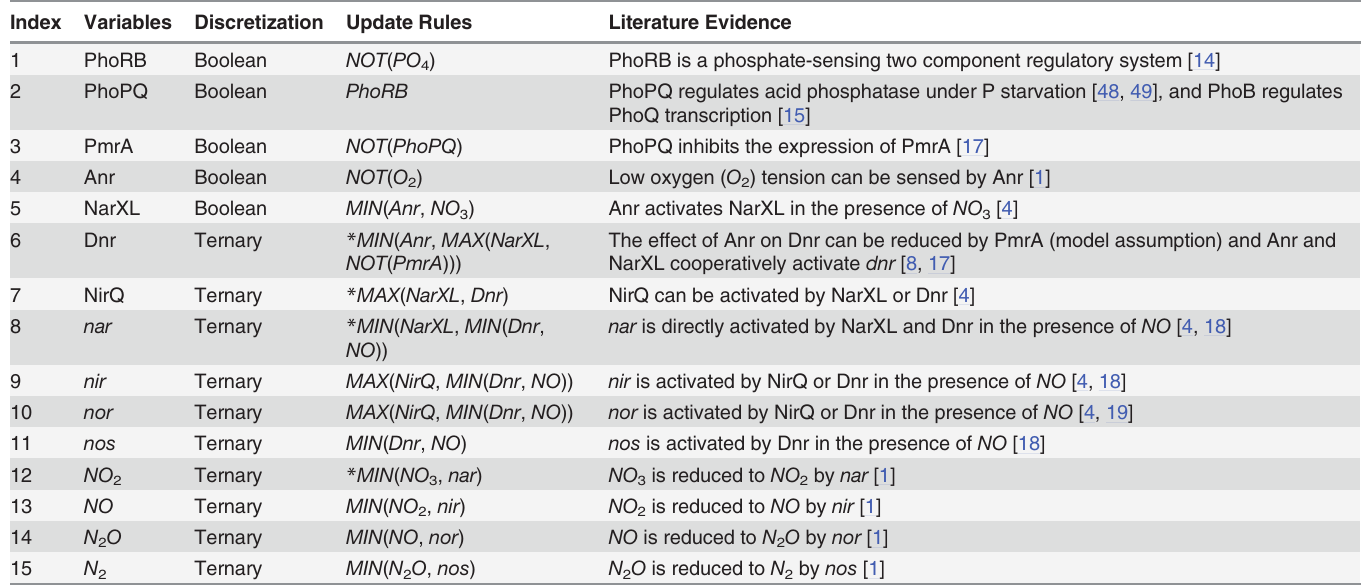
Table 3. Summary of the model variables, their discretization, update rules and supportive argument. The update rules with an asterix ( * ) means this update rule is very close to the biological correspondence but not quite. The transition tables of the variables having update rules with an asterix ( * ) can be found in the Supplementary